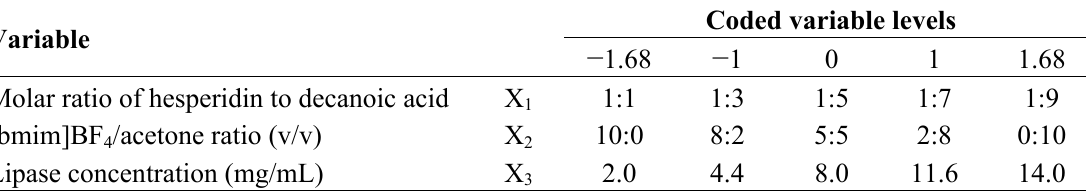
Table 1. Variable and levels for central composite design in the enzymatic acylation